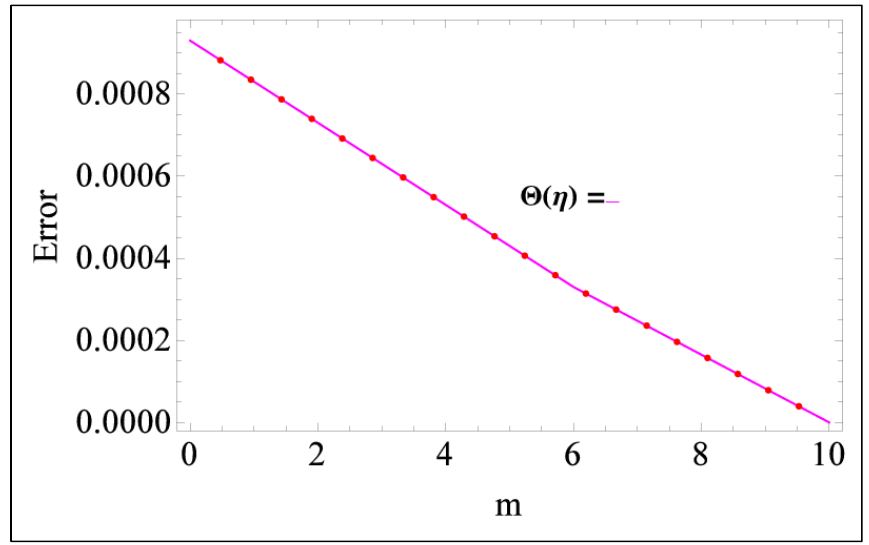
Figure 3. Total residual error in case of CNTs-Water for the temperature profile.